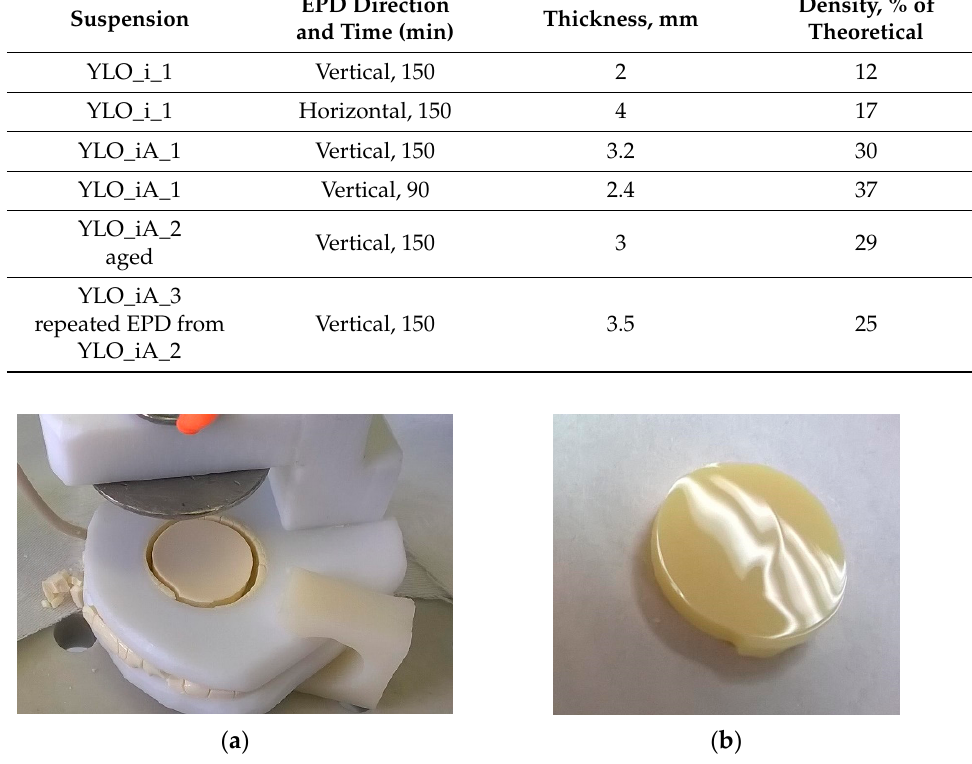
Figure 9. Dry compact obtained by vertical EPD from YLO_iA_1 suspension: ( a )–at the beginning of the drying process in the cell; ( b ) dry compact. Table 2. Suspensions, EPD parameters, size and density of the green bodies.